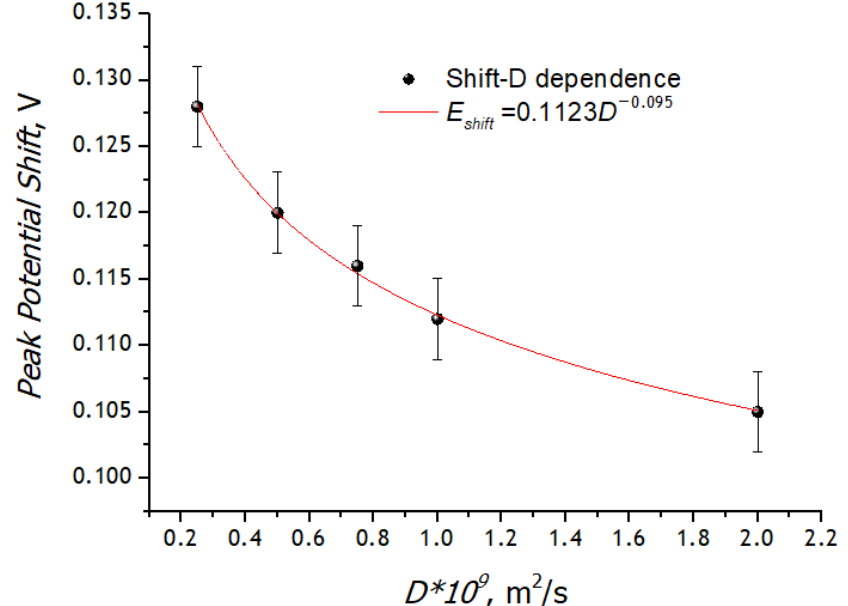
Figure 11. Dependence of the potential shift on the diffusion coefficient for an ensemble with an interelectrode distance of 20 µm and a sweep rate of 1000 mV/s.